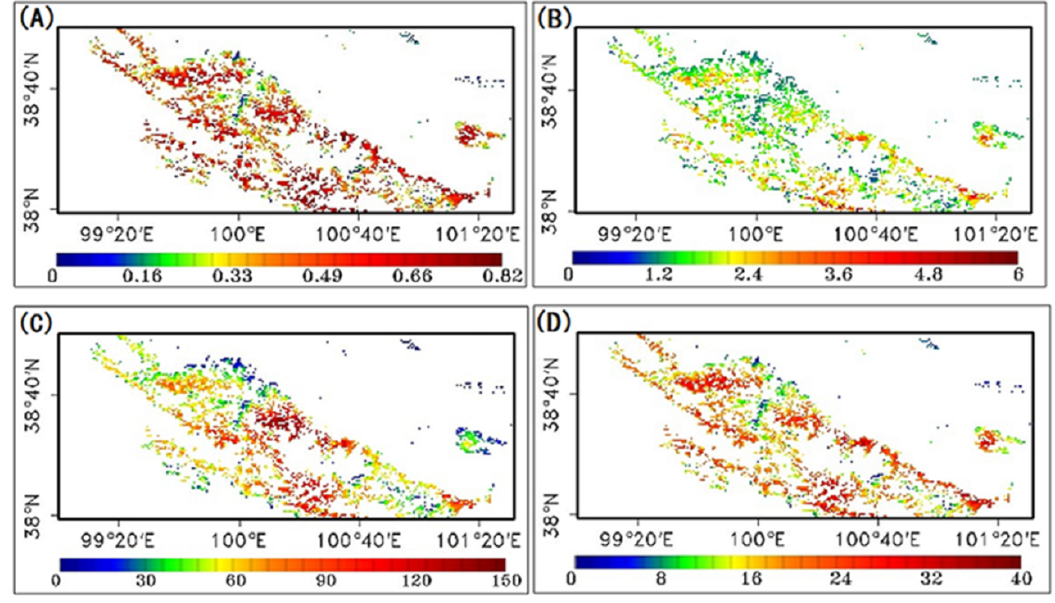
Figure 5. The spatial distribution of ( A ) the Fractional Vegetation Cover (FVC); ( B ) the Vegetation Area Index (VAI); ( C ) the interception loss (mm); and ( D ) the interception loss in percentage of gross rainfall (%). Values in the maps are the average over the period from 13 June to 7 October